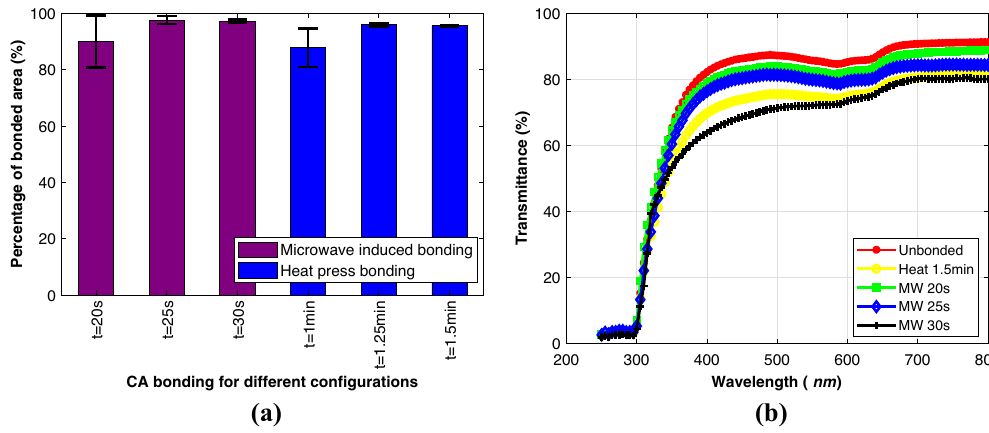
Figure 3. ( a ) The average bonded area (%) for different configurations of CA bonding using ImageJ software. The X-axis denotes different configurations and Y-axis denotes the percentage of bonded area. Minute is represented by “min” and second by “s”. ( b ) The transmittance (%) after bonding for different CA configurations. The ‘MW’ represents microwave induced and ‘Heat’ represents heat press based bonding in the figure. Minute is represented by “min” and second by “s”.